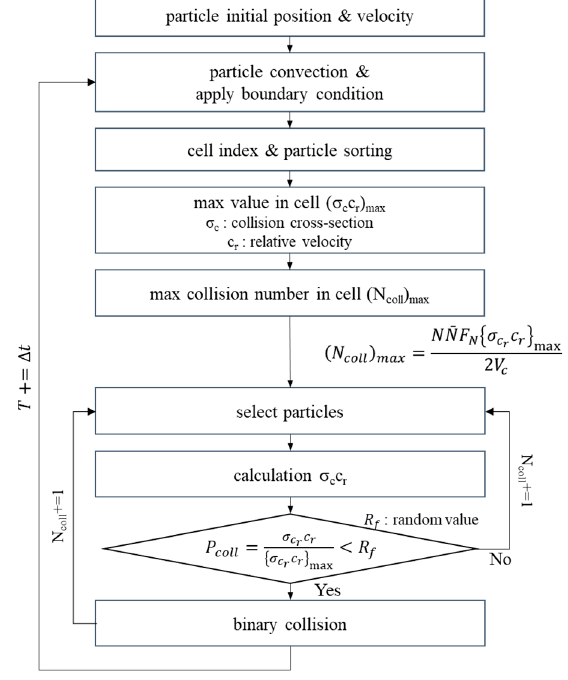
Figure 1. DSMC algorithm process.